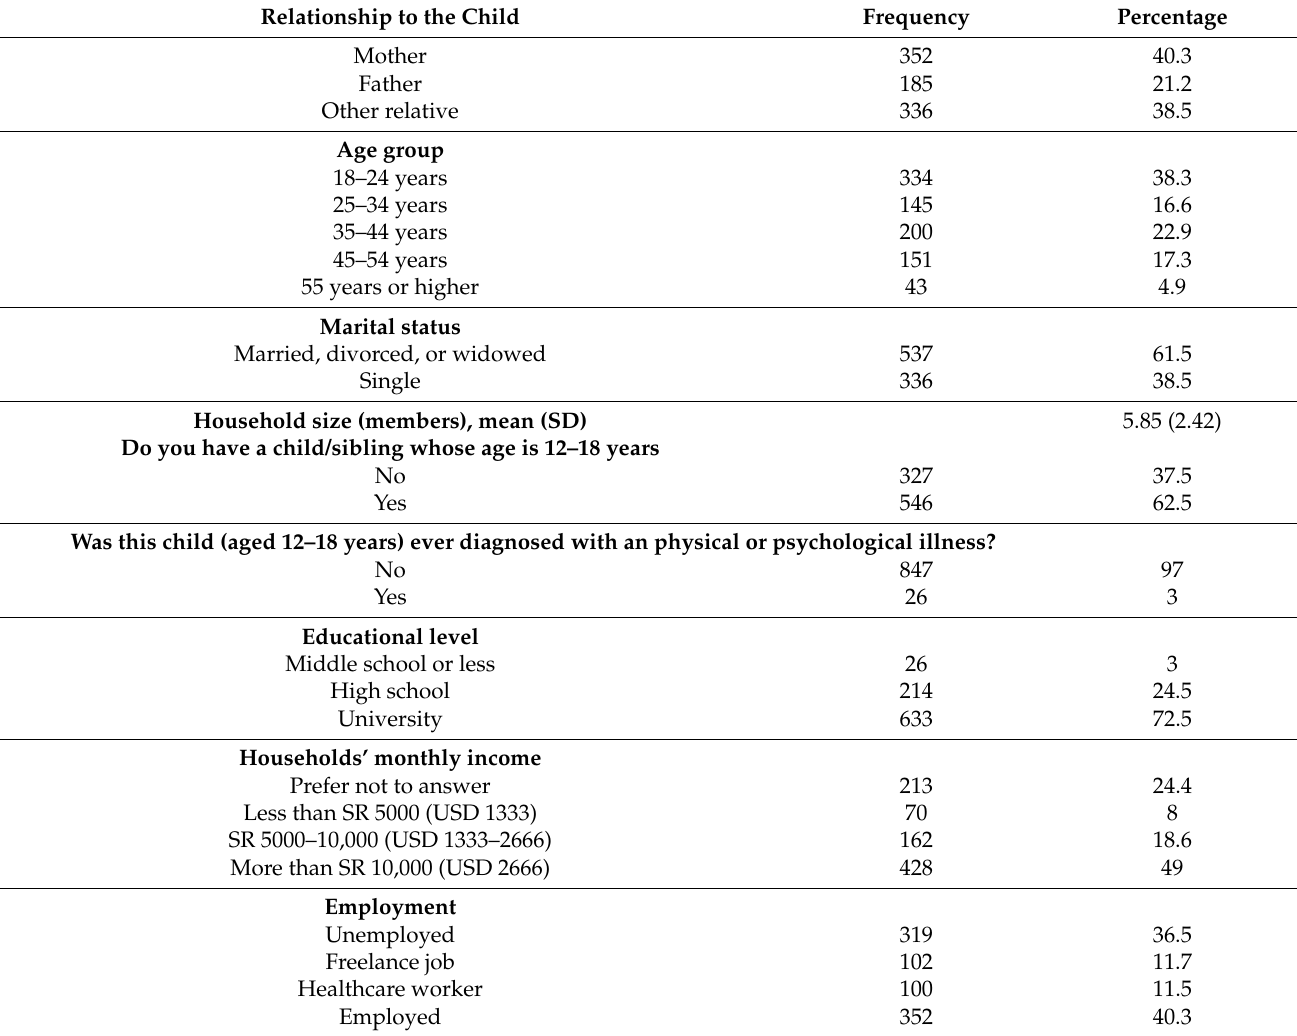
Table 1. Parental sociodemographic characteristics. N =